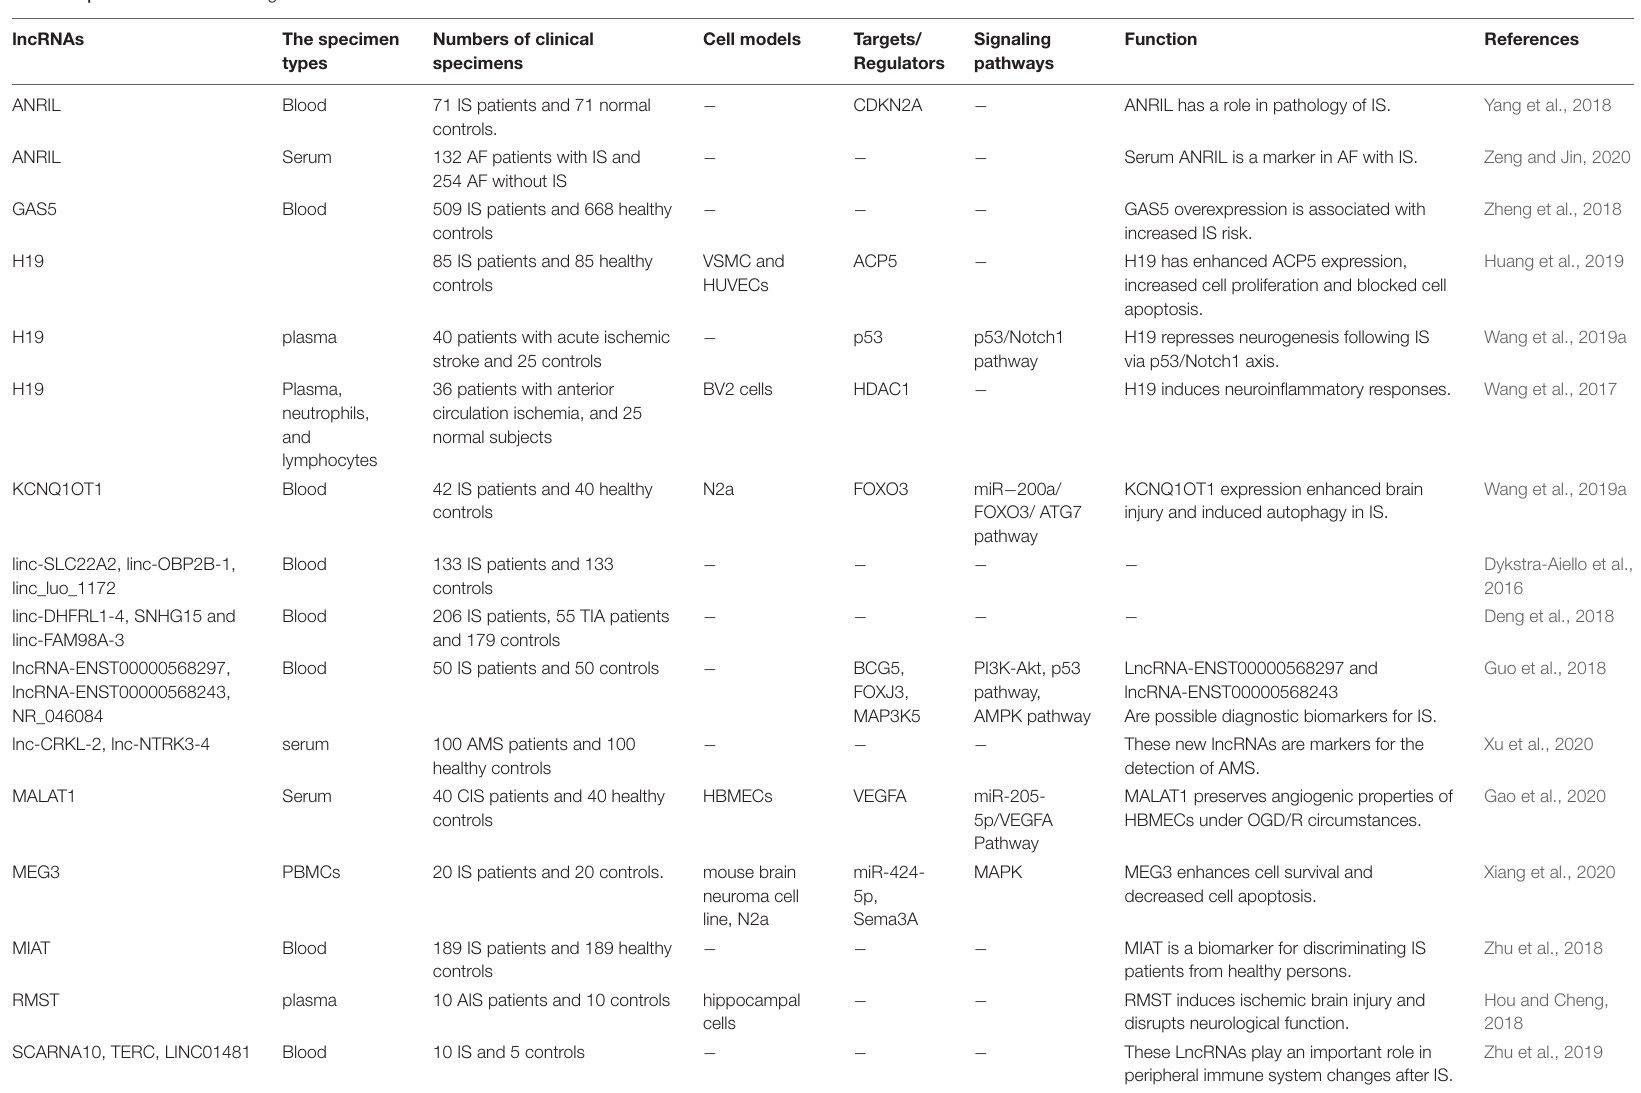
Zhu et al., 2018 Zhu et al.,